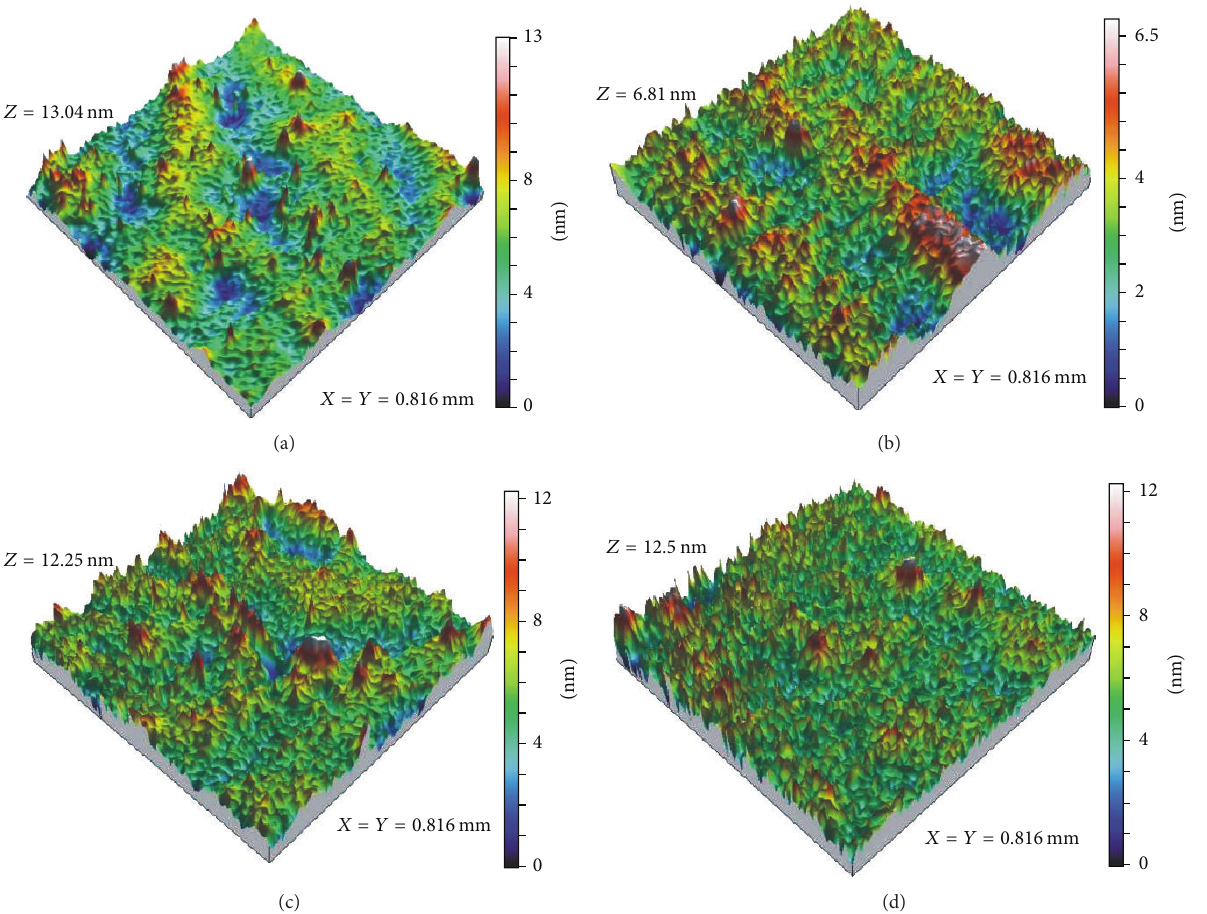
Figure 8: 3D surface topography profiles of prepared thin films: (a) TiO 2 , (b) TiO 2 :(1 at. % Nd), (c) TiO 2 :(3 at. % Nd), and (d) TiO 2 :(6 at. % Nd).